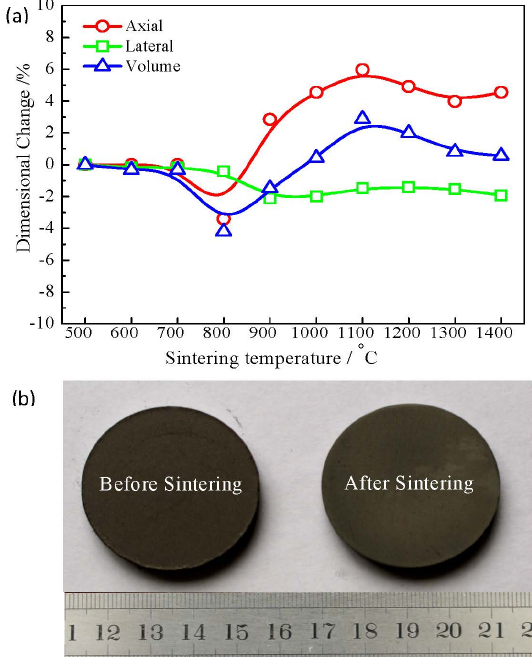
Figure 4. ( a ) Axial, lateral and volume size changes of the compacts sintered at different temperatures; ( b ) Photos of porous compacts before and after sintering